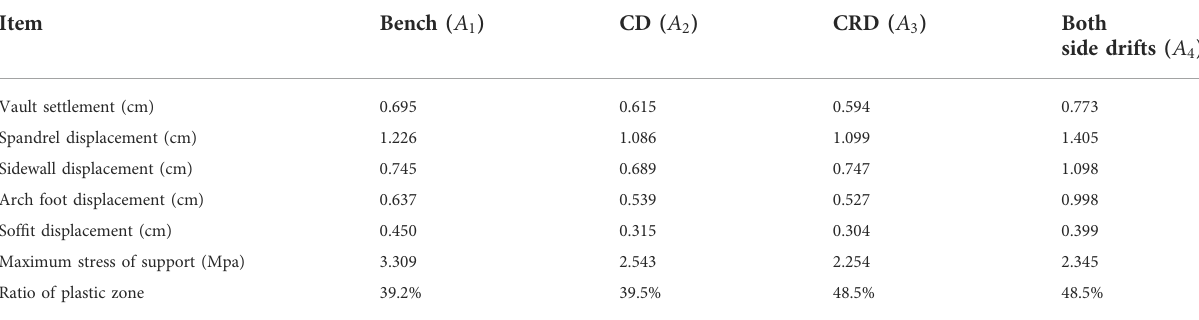
TABLE 6 Numerical simulation results of tunnel section in alternative excavation scheme.